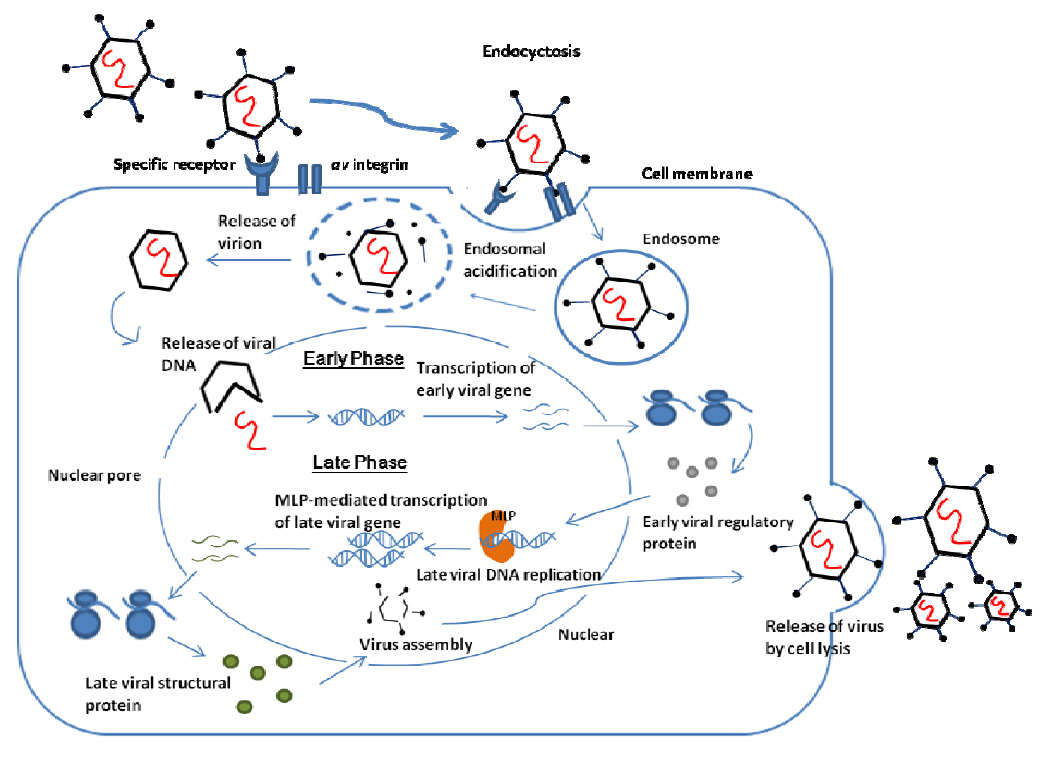
Figure 2. Adenovirus infection and replication